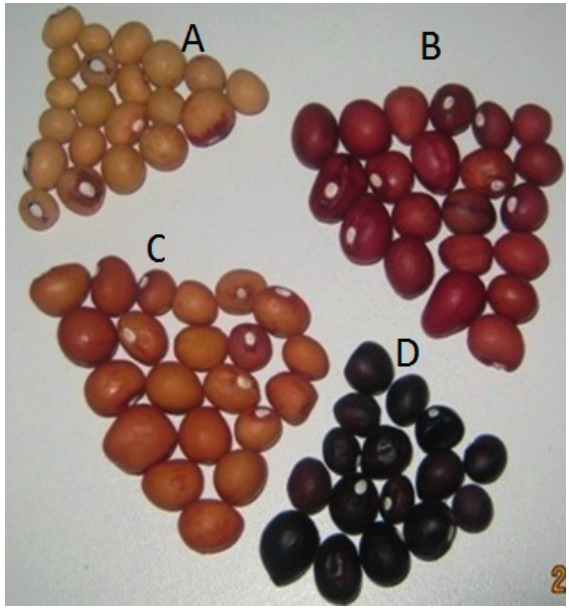
Figure 5. A single Bambara groundnut landraces characterised on the basis of seed coat colour; A —Light-brown, B —Red, C —Brown, and D —Black. Source